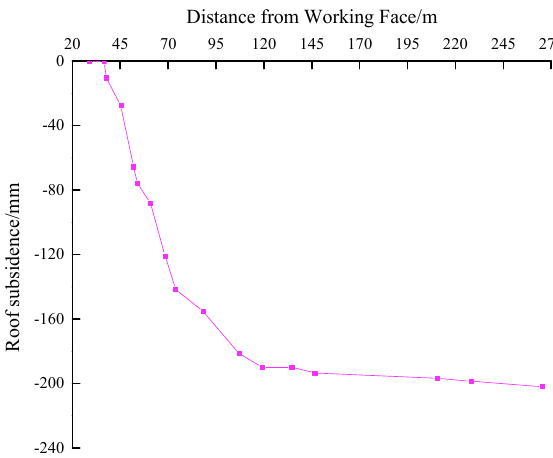
Figure 16. Working conditions of a hydraulic support in solid backfill mining.